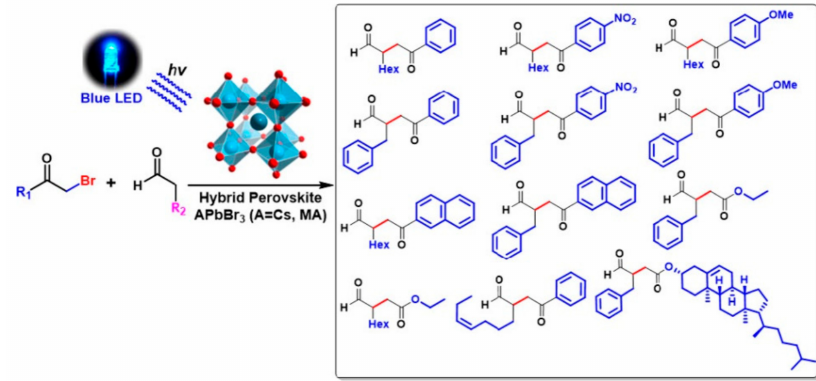
Figure 18. Scheme of α -alkylations reactions catalyzed by hybrid MAPbI 3 , perovskites. Reprinted with permission from [312], Copyright (2019) American Chemical